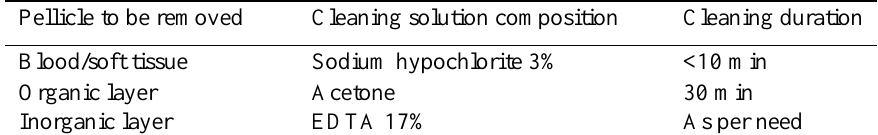
Table 1. Protocol for cleaning of the retrieved dental